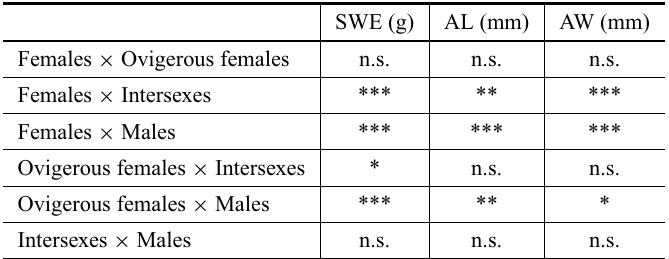
Shell species occupied by the hermit crab Clibanarius vittatus . Dunn’s multiple comparisons (p < 0.05) between the hermit crab sexes in the morphometric variables of occupied shells (H=157.53). SWE (g) AL (mm) AW (mm) Females × Ovigerous females n.s. n.s.